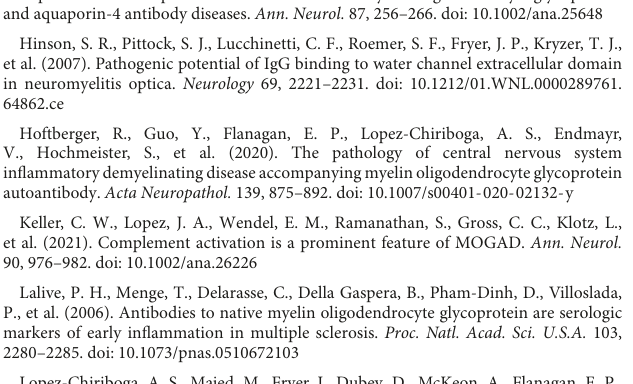
SUPPLEMENTARYTABLE1 Profile of the patients included in the study. ADEM, acute disseminated encephalomyelitis; ON, optic neuritis; MS, multiple sclerosis; NMO, neuromyelitis optica; EM, encephalomyelitis; TM, transverse myelitis; OIND, other inflammatory neurological disease; NIND, non-inflammatory neurological